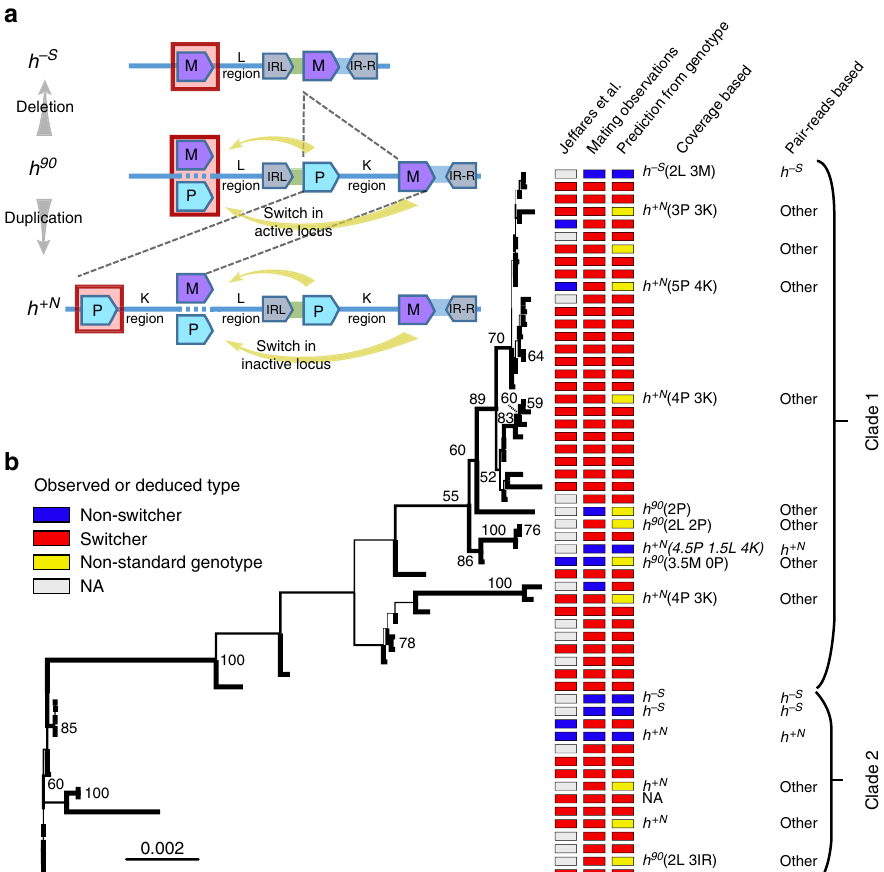
Fig. 1 The genomic organization of the mating-type region in wild strains and world-wide diversity of switchers and non-switchers. a Schematic of the genetic arrangement for switcher ( h 90 ; middle) and the two most common non-switcher phenotypes ( h – S and h + N ; top and bottom, respectively). Regions are not to scale. The switcher ’ s active mating-type locus mat1 (red box) switches between Plus (P) and Minus (M), using the silent cassettes as templates during cell division. The non-switcher strain h – S contains only the minus cassette, due to deletion of part of the silent region. The non-switcher strain h + N is the result of a duplication of almost the entire silent mating type and only expresses the P cassette at mat1 (see ref. 9 ). b The unrooted maximum-likelihood tree for 57 natural fi ssion yeast isolates, based on the L region (results for the 3 ʹ and 5 ʹ fl anking region of entire mating-type region in Supplementary Fig. 3), results in two main clades (indicated by brackets). Branch values show bootstrap support when >50. Colour codes indicate switching phenotypes based on (i) previous observations 35 , (ii) our test of single-cell colony mating (mating observations) or (iii) the prediction from inferred genotype. Genotypes were predicted based on the coverage and paired-read analyses, as shown in the last two columns (only shown when differing from the h 90 haplotype). When genotypes differ from the standard con fi gurations ( a ), additional information on predicted number of copies for the L- and K-region, and P- and M-cassette (Supplementary Fig. 1) is presented between brackets. The samples that do not fi t any existing genotypes in b are labelled as ‘ other